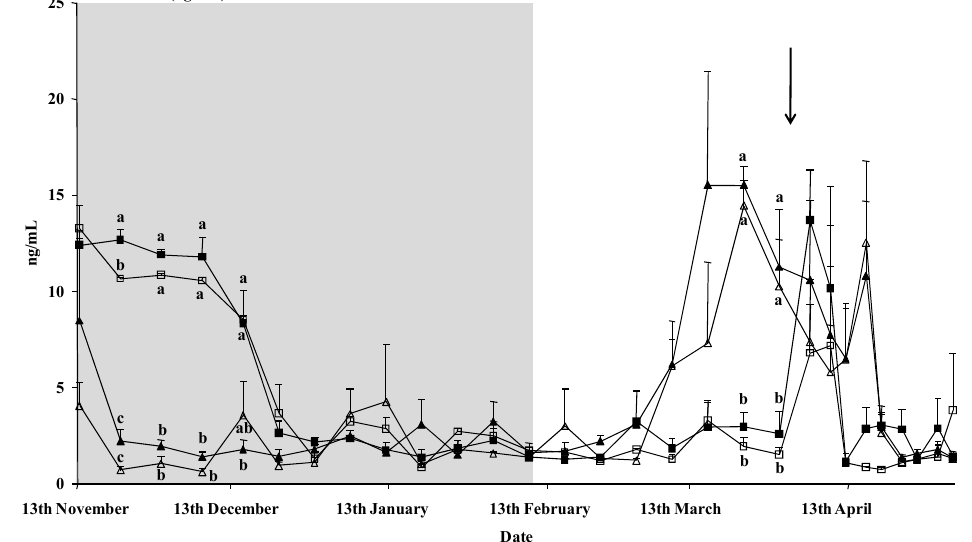
Figure 2. Plasma testosterone concentration (ng/mL) of bucks of Murciano–Granadina breed (filled symbols) or Blanca Andaluza breed (empty symbols) subjected to the photoperiodic treatment, i.e., long days for three months between November and February (photo; triangles) or not (control; squares). The shaded area indicates the time of the photoperiod treatment. The arrow indicates D0, when the male effect was applied. Values with different letters (a, b, c) are different ( p < 0.05).